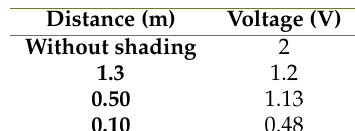
Fig. 6. The acquisition part of our interface Table 4. Variation of the voltage according to the distance of the obstacle Distance